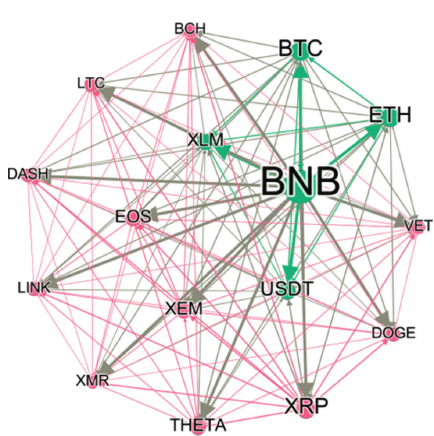
Figure 44: Risk spillover under E6.